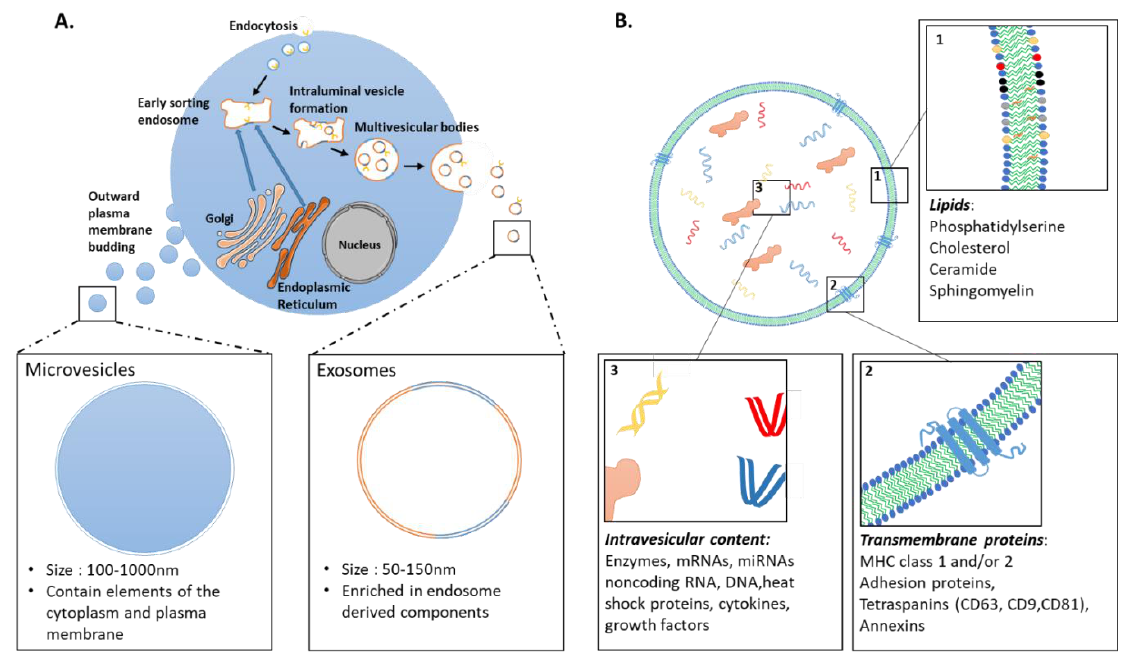
Figure 1. Biogenesis and general composition of EVs. ( A ) Scheme describing the biogenesis of EVs: Microvesicles are produced via the outward budding of the plasma membrane whereas exosomes arise from the fusion of multivesicular bodies with the plasma membrane. Early sorting endosomes receive materials from endoplasmic reticulum, golgi and the endocytic pathway. Multivesicular bodies are generated through the formation of intraluminal vesicles in the late sorting endosome. ( B ) Illustration of nucleic acids, proteins and lipids that can be present in EVs (this list is not exhaustive). Exact nature of EV cargo depends on the cell type, culture conditions (i.e., stress) and pathological state.